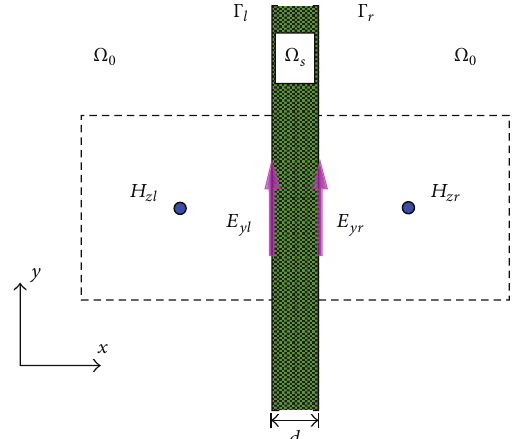
Figure 2: Configuration of a TCL illuminated by a TEz plane wave.